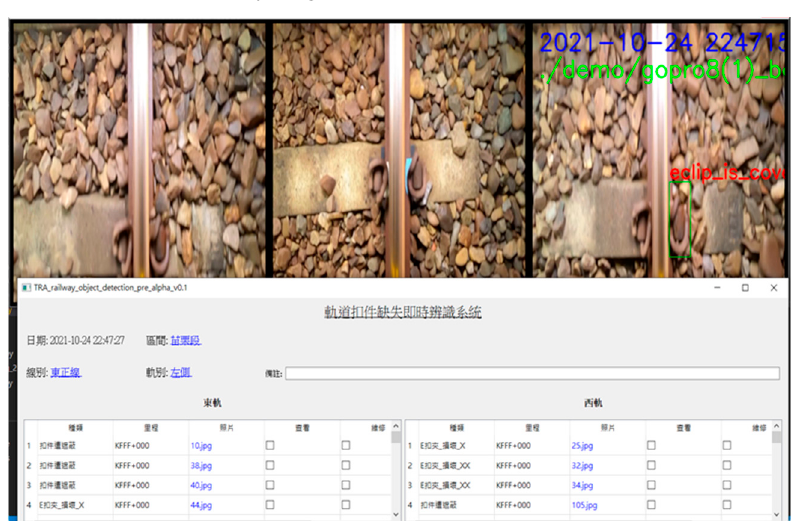
Figure 3. The interface of the track fault detection system.